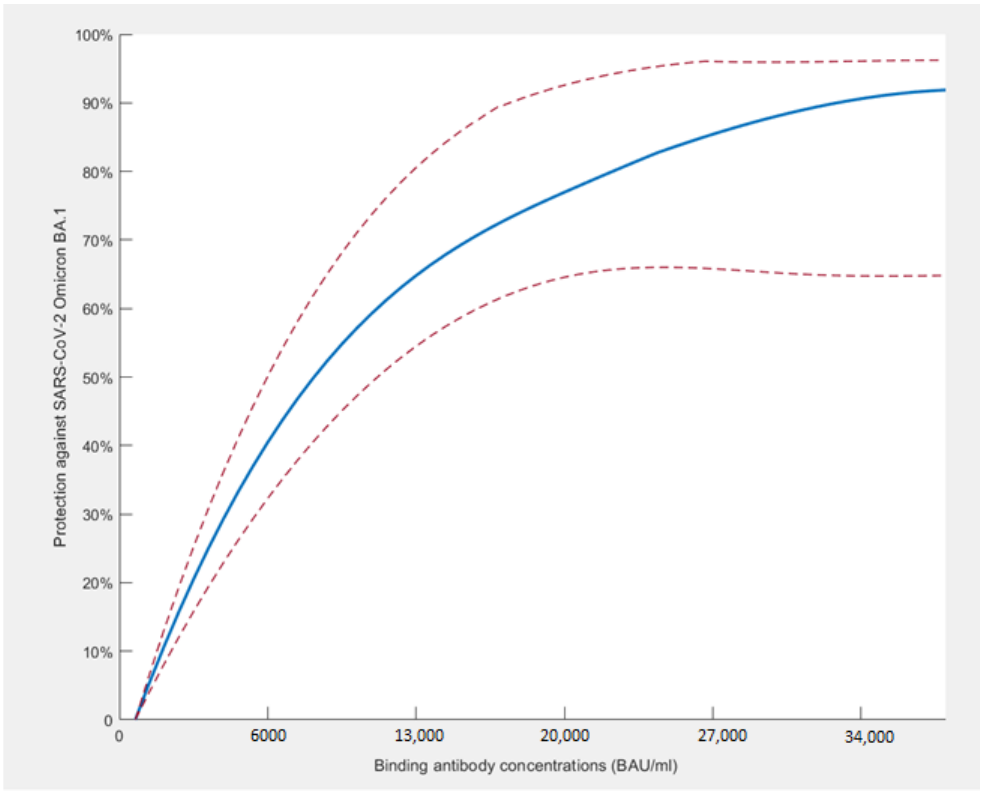
Figure 5. Binding antibody concentrations and protection against SARS-CoV-2 Omicron BA.1 infection/re-infection by spline interpolation (95% CI: dotted line).